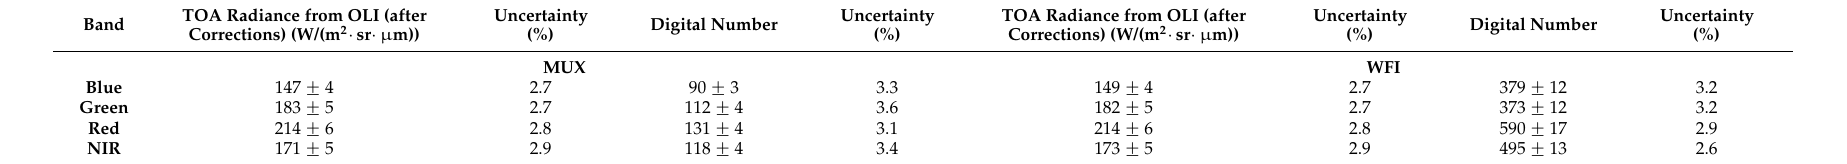
Table 7. Landsat-8/OLI and CBERS-4 (MUX and WFI) cross-calibration results using Libya-4 site.